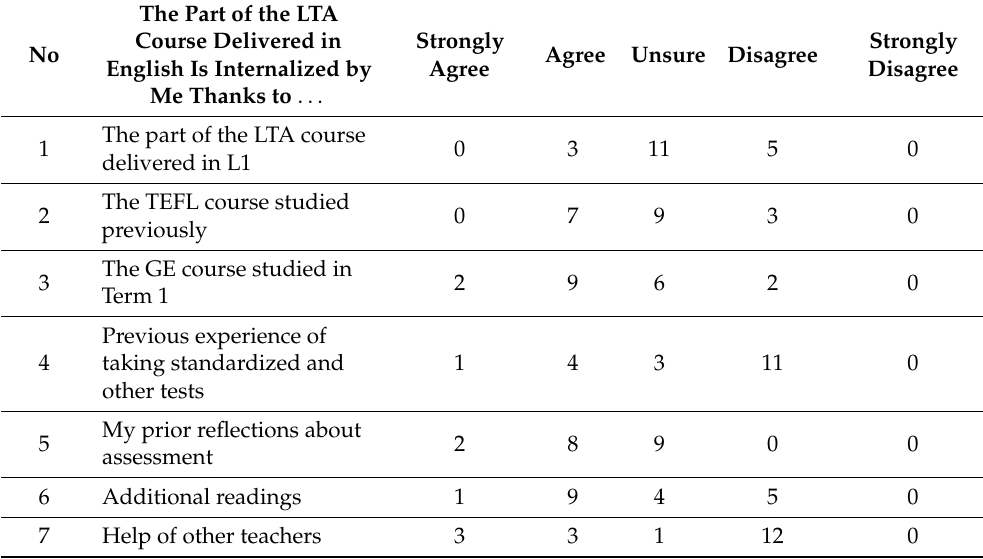
Table 8. Perceptions of impact of prior experience on the learning outcomes in the LTA course